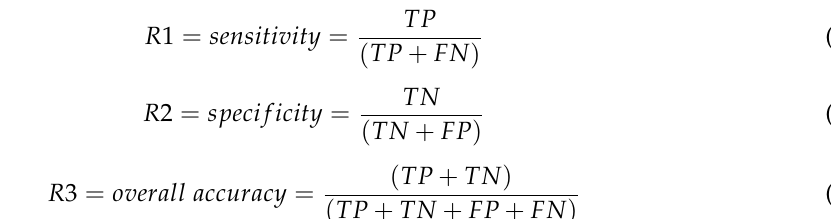
Figure 19. The frequency variations during grid faults occur. Table 3. Voltage relay responses.